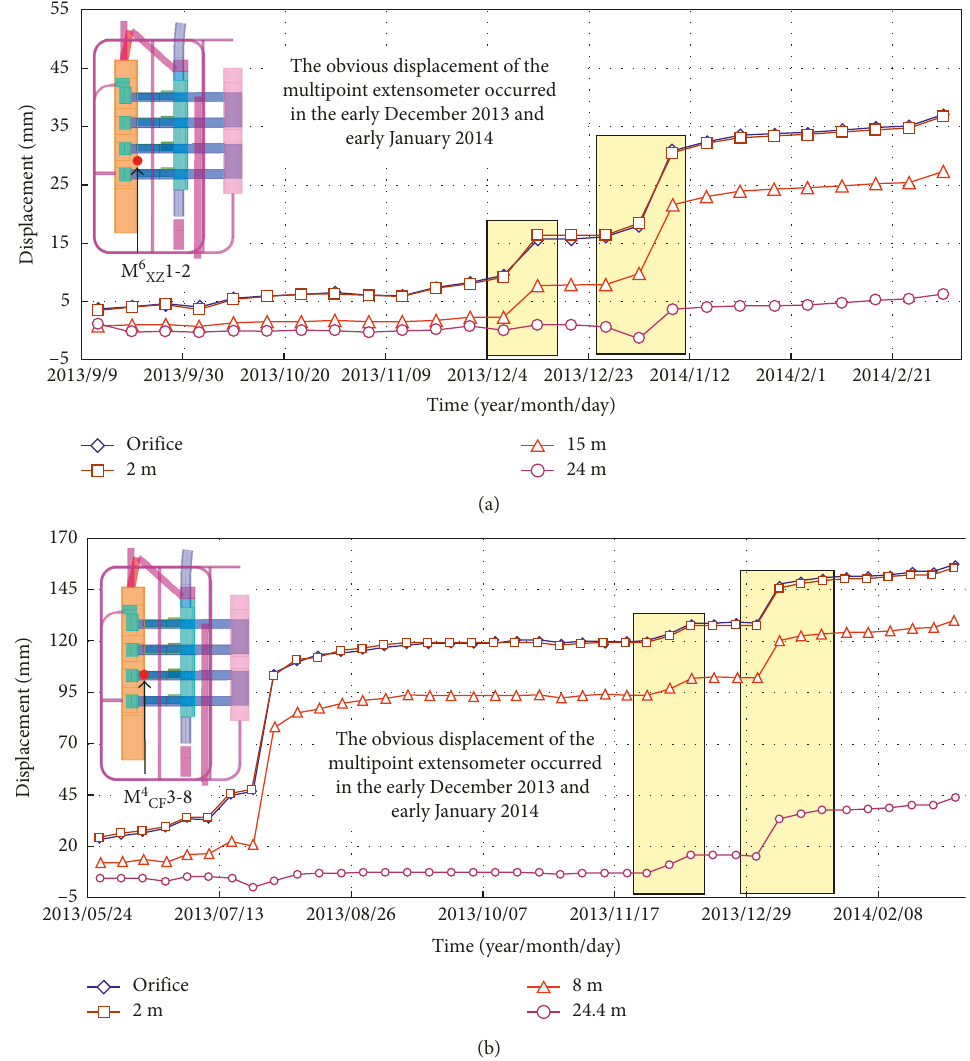
Figure 4: Monitoring data of multipoint extensometers: (a) the displacement process curve of M 6 curve of M 4 CF